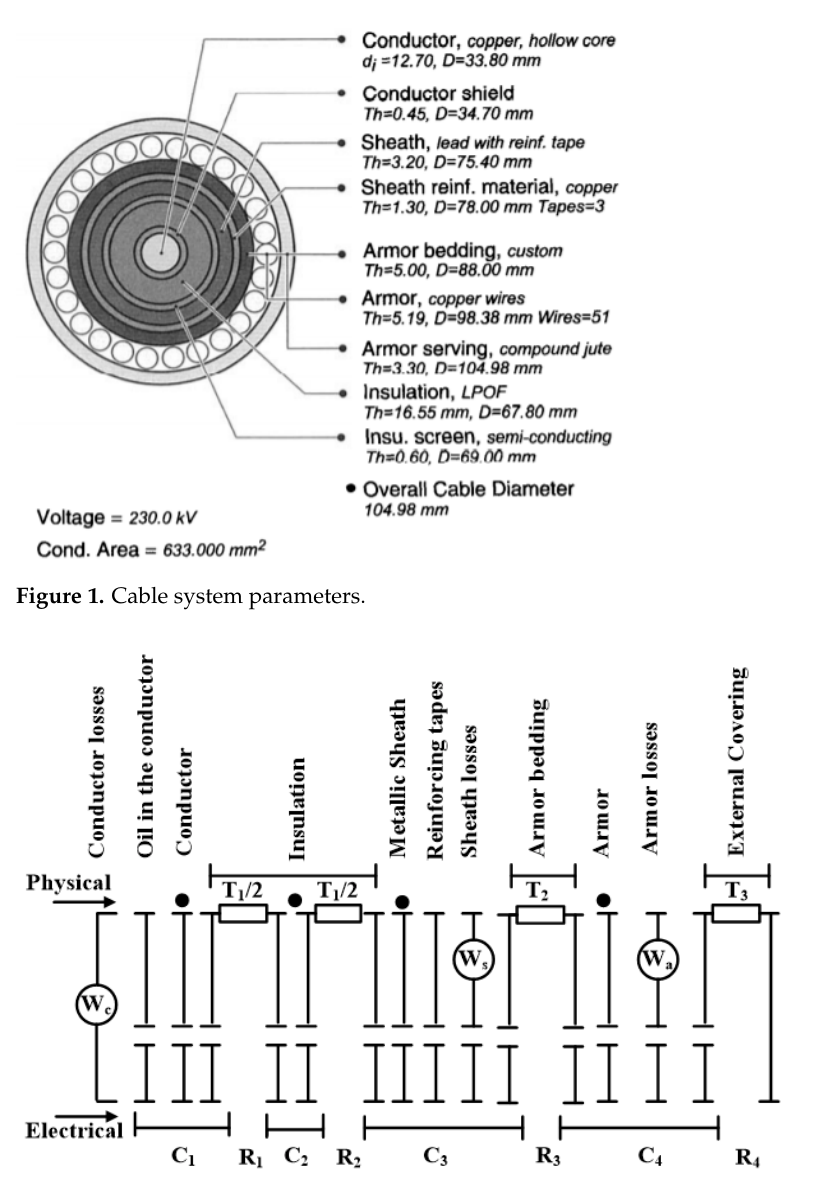
Figure 2. Equivalent thermal circuit representing the cable system in Figure 1 indicating the physical and equivalent electrical parameters.